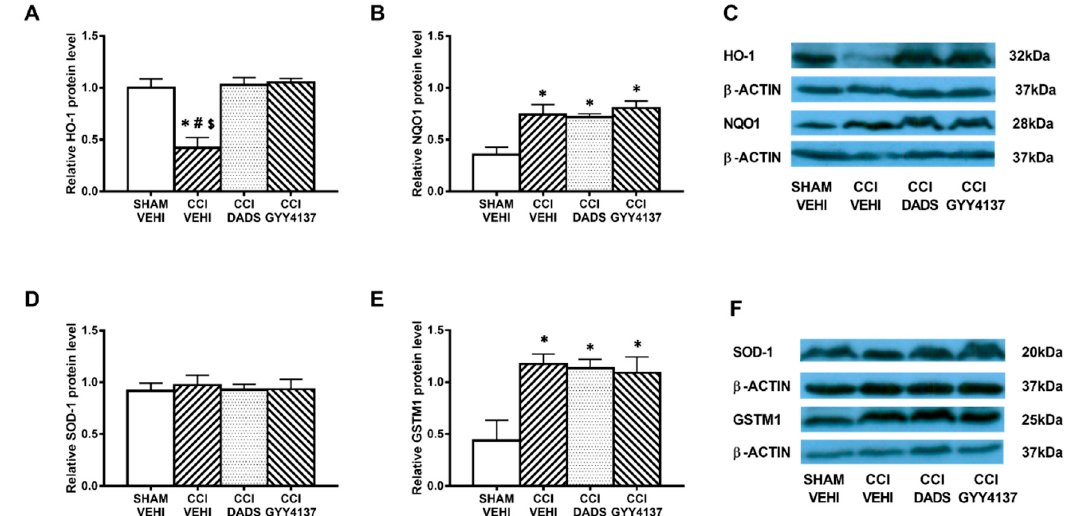
Figure 6. The effects of DADS and GYY4137 on the expression of HO-1, NQO1, SOD-1, and GSTM1 in the AMG of animals with neuropathic pain. Treatment with DADS and GYY4137 normalized and/or increased the protein levels of HO-1 ( A ), NQO1 ( B ), and GSTM1 ( E ) in the AMG of animals with CCI-induced neuropathic pain. No changes in the expression of SOD-1 ( D ) were detected. We used sham-operated mice treated with vehicle as controls. Proteins are expressed relative to β -actin protein levels. Representative blots for HO-1, NQO1, and β -actin ( C ) and for SOD-1, GSTM1, and β -actin ( F ) are shown. In all panels, * represents significant differences vs. sham-operated mice treated with vehicle; # vs. sciatic nerve-injured mice treated with DADS; and $ vs. sciatic nerve-injured mice treated with GYY4137 ( p < 0.05; one-way ANOVA followed by the Student–Newman–Keuls test). Mean values ± SEM; n = 3–4 samples.